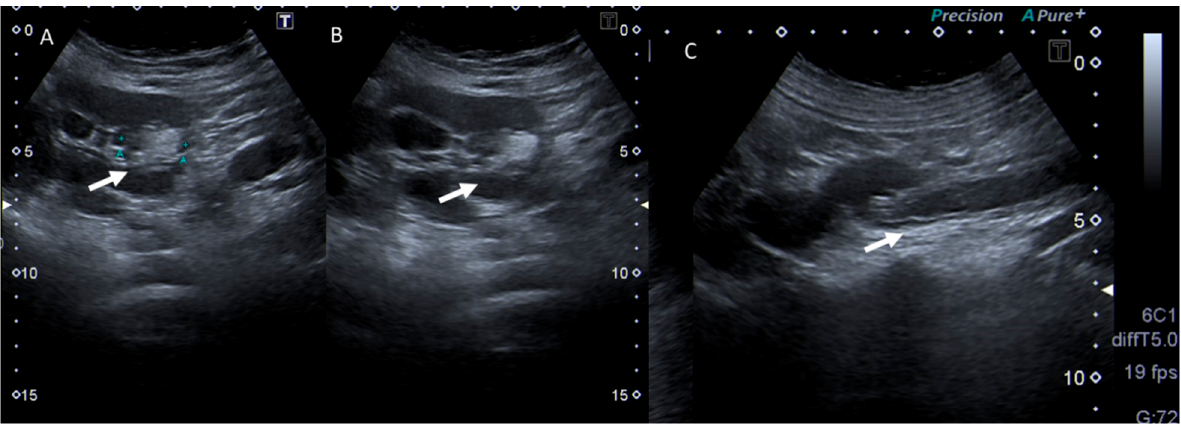
Figure 4. Pregnant woman with left flank pain and fever. US assessment shows in ( A , B ) hydroureteronephrosis with caliceal hyperechoic material (arrows) and thickening of the ureteral walls ( C ).